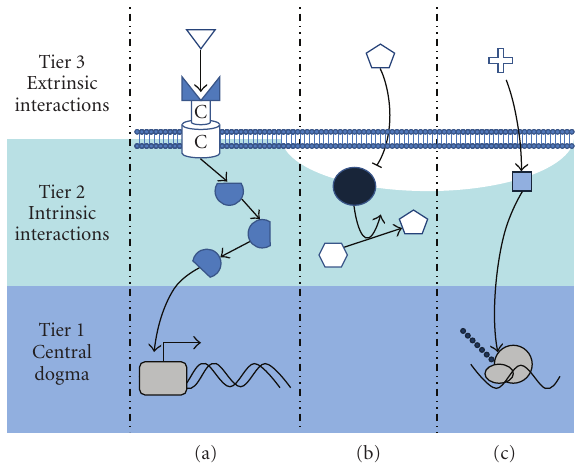
Figure 2: Interaction of components illustrating synthetic biology at the three tiers . (a) Canonical signalling pathway depicting a tier three ligand-receptor binding event that induces a tier two phosphorylation cascade which subsequently alters a promoter at the first tier. (b) Canonical allosteric protein inhibition by a molecule downstream in the pathway. The inhibition binding event is a tier three interaction which results in a tier two alteration in the pathway “set point.” (c) Hypothetical signalling pathway in which a signal molecule alters an initiation factor at tier three which then changes the tier two protein translation set